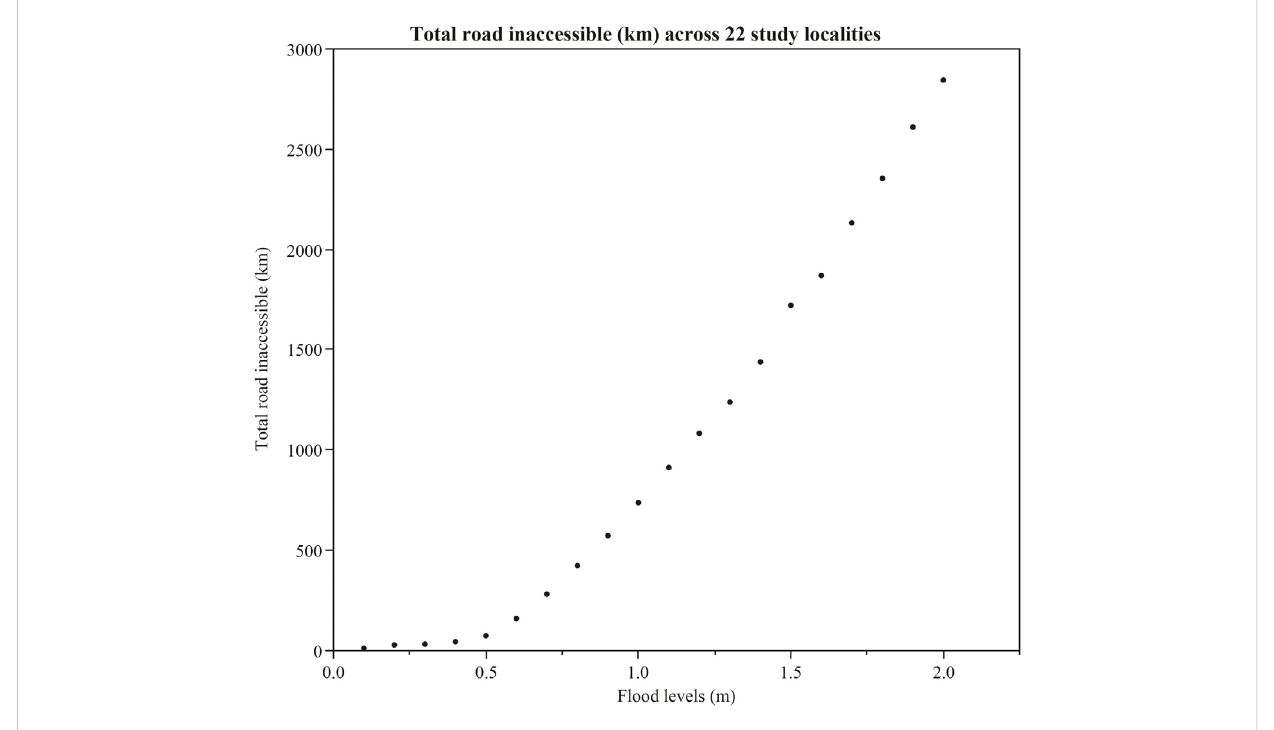
FIGURE 2 Total road inaccessible length across the 22 studied localities at each fl ood